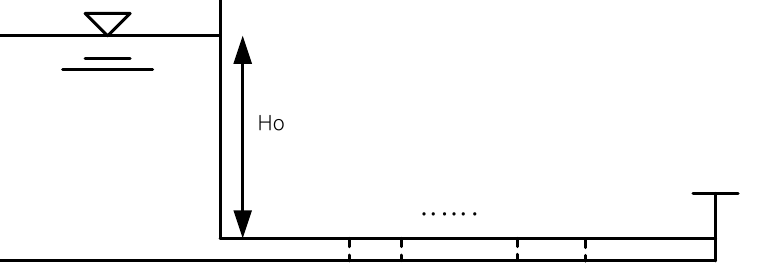
Figure 1. A reservoir pipeline valve (RPV) system with multiple